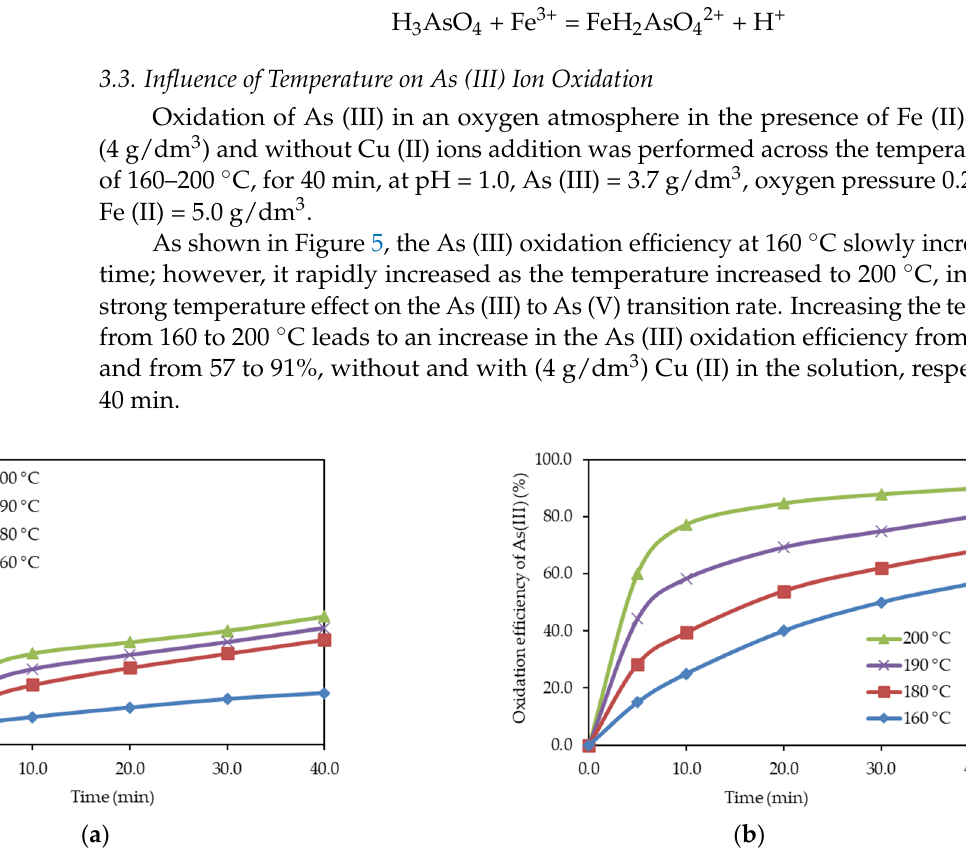
( d ) Figure 6. As (III) and Fe (II) oxidation efficiency as a function of temperature with ( a , c ) and without ( b , d ) Cu (II) ions. Oxygen pressure has a significant effect on the As (III) and Fe (II) ions oxidation in solution. An increase in oxygen pressure from 0.2 to 0.5 MPa leads to an increase in the oxidation efficiency of As (III) and Fe (II), from 36.9 to 72.5% and 66.1 to 80.3%, respec- tively, within 40 min. Introduction of Cu (II) ions into the solution also had a positive